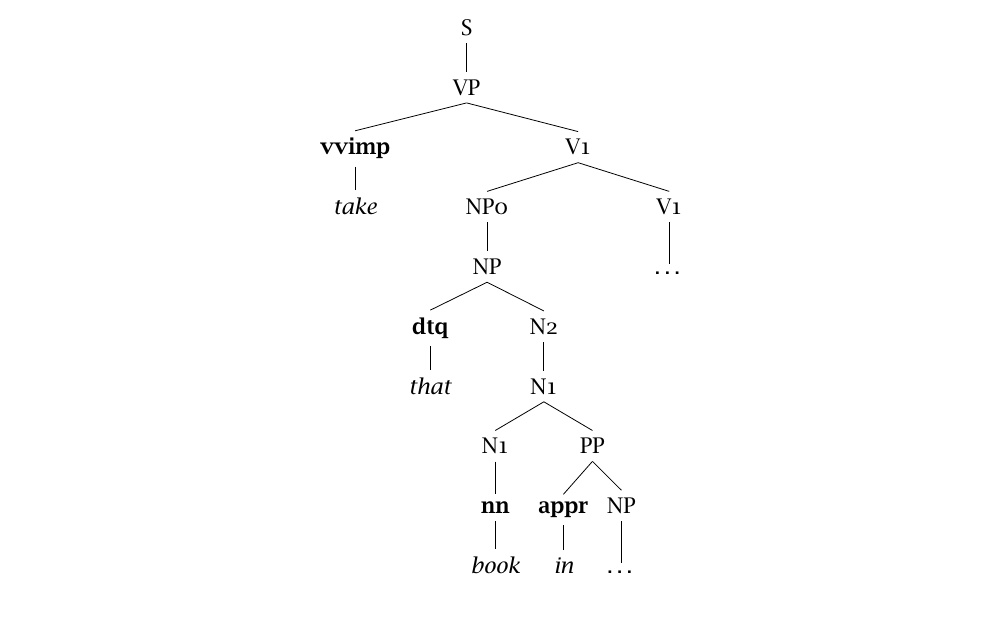
Incremental syntactic derivation of a simple example